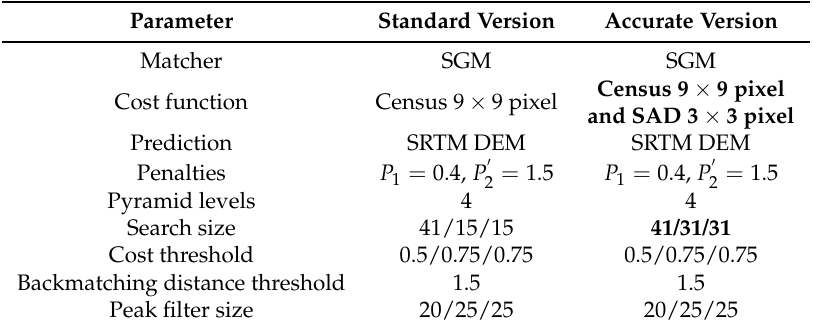
Table 10. Main parameters used for stereo matching: Two sets are defined, namely the standard version and the more accurate version. Differences in the parameters are marked in bold